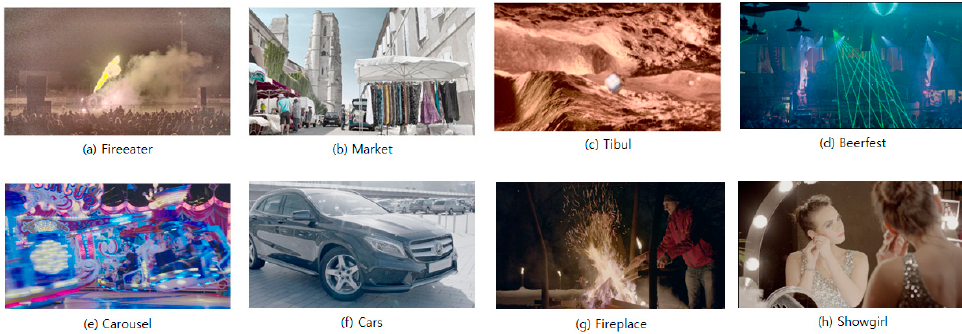
Figure 3. Representative images for selected HDR/WCG test sequences.